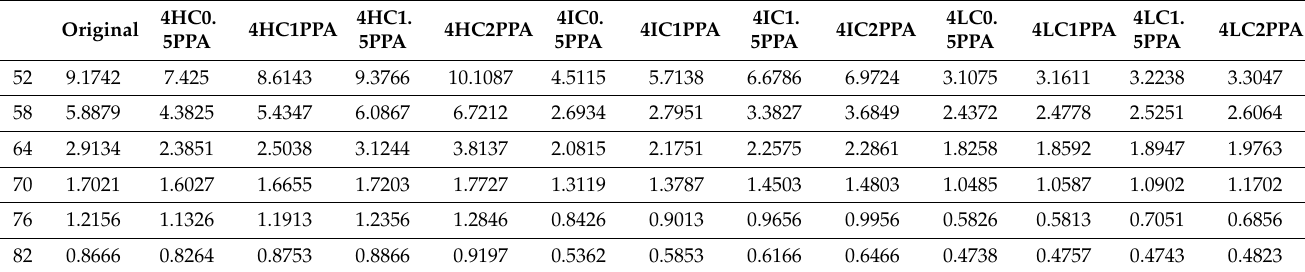
Table 6. Average Shenoy parameter